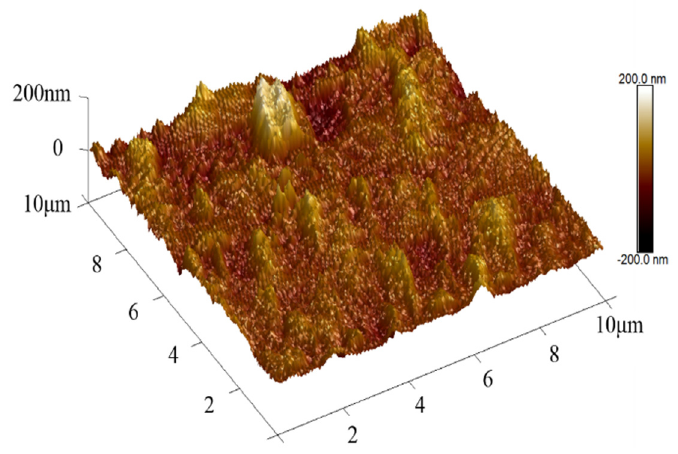
Figure 1. XRD of h-BN coatings.